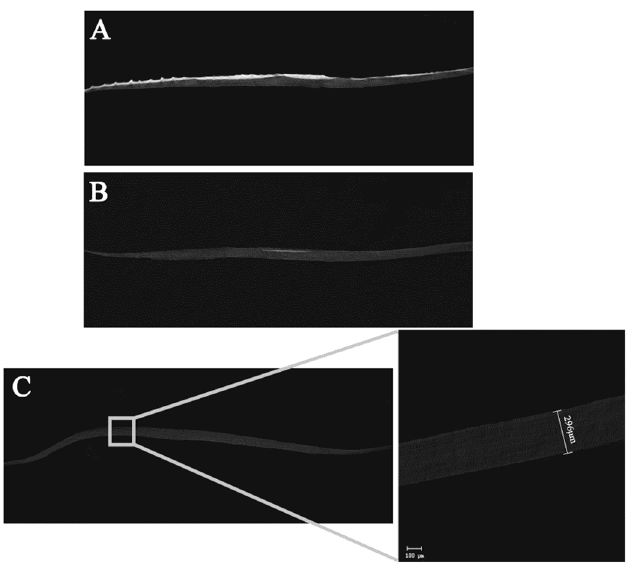
Figure 4. Results of micro-CT. Fresh fish scale ( A ), decalcified fish scale ( B ), fish scale collagen lamellar matrix ( C ).